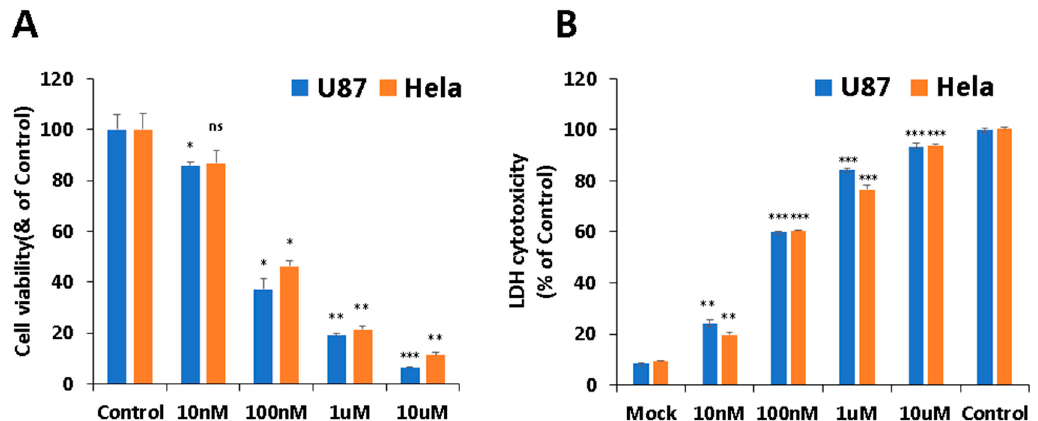
Figure 2. Cell cytotoxicity of PB11 in cancer cells. U87 and HeLa cells were grown in 96-well culture plates with 0 nM, 10 nM, 100 nM, 1 μ M, or 10 μ M PB11. After 48 h, the cytotoxicity of PB11 was evaluated by determining the number of viable cells via the 2,5-diphenyl tetrazolium bromide (MTT) assay ( A ) or by determining the amount of lactate dehydrogenase (LDH) released into culture ( B ). The cell viability and released LDH amount are presented as percentages of the control (mock-treated cells in ( A ) and lysed untreated cells in ( B )). Based on the dose-response curves, the IC50 for PB11 was estimated to be approximately 40 nM. All data are expressed as mean ± SEM. Statistical significance was analyzed with the two-paired Student’s t-test; ns = p > 0.05, * = p < 0.05, ** = p < 0.01, and *** = p < 0.001.